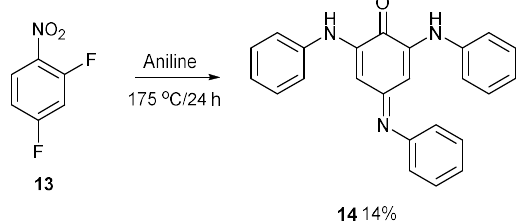
Figure 4. Synthesis of compound 14 .